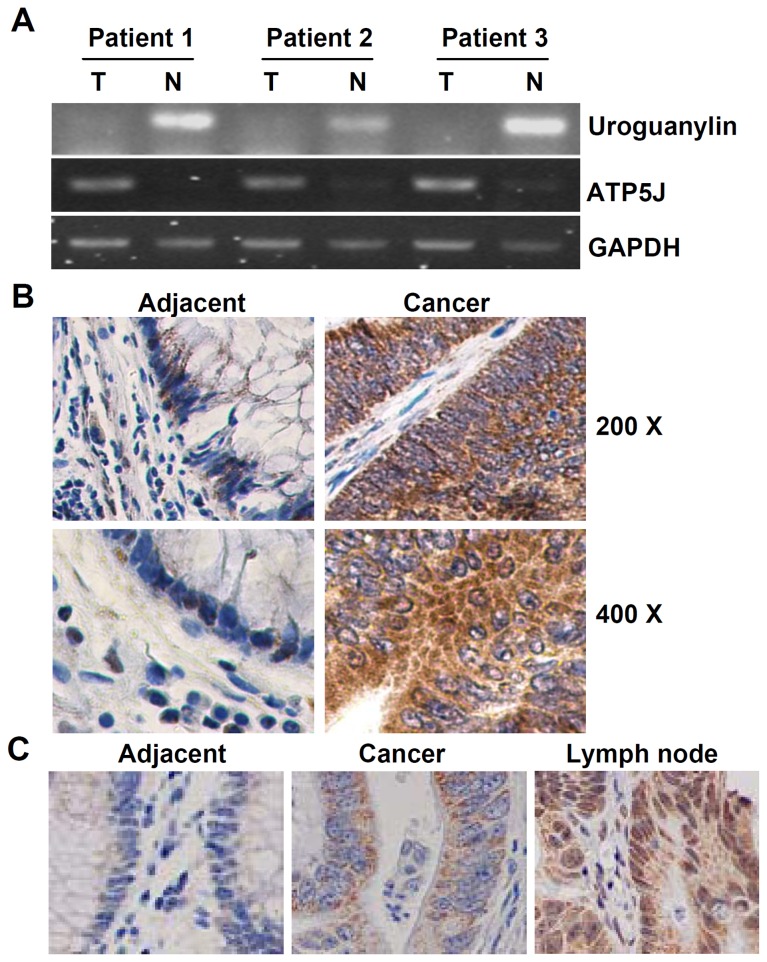
Condition of ATP5J expression in colorectal cancer patients.(A) RT-PCR results for the ATP5J and uroguanylin genes. (B) Immunohistochemical staining results for adjacent tissue and cancer tissue. (C) Immunohistochemical staining results for adjacent tissue, cancer tissue, and metastatic lymph node tissue.